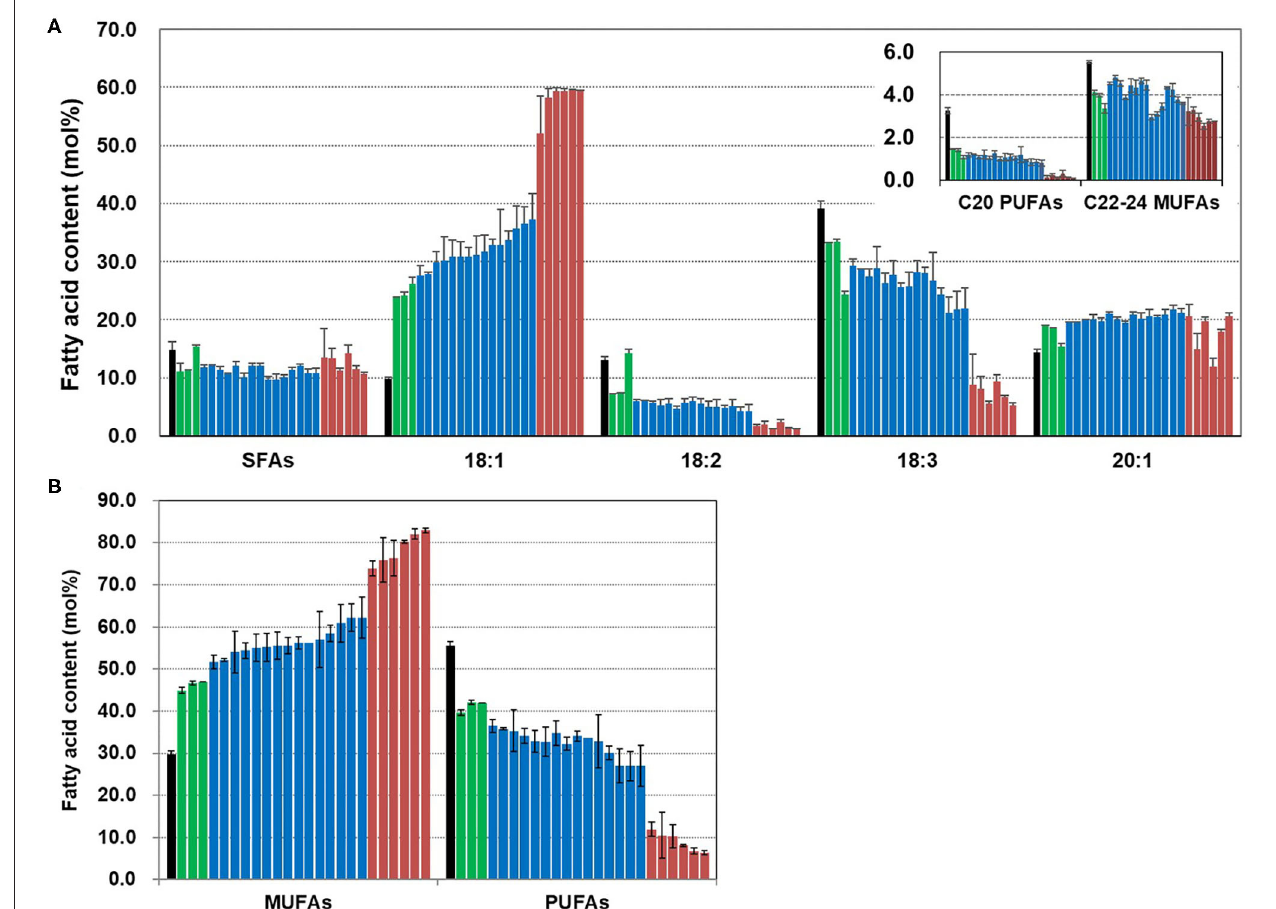
FIGURE 5 | Fatty acid analysis of CsFAD2 KO T 4 Camelina seeds. (A) Fatty acid composition of CsFAD2 KO Camelina seeds showing high-oleic and low-PUFA traits. SFAs, saturated fatty acids containing 16:0, 18:0, 20:0, 22:0, and 24:0; C20 PUFAs, 20:2, and 20:3; C22-24 MUFAs, 22:1, and 24:1. (B) MUFA and PUFA contents of CsFAD2 KO Camelina seeds. Black, green, blue, and brown bars represent WT, aa/bb/CC, aa/bb/Cc, and aa/bb/cc, respectively. The line numbers of green, blue and brown bars are in order as follows. Green bar, EC#5-1-5-2 (EC# is omitted hereafter), 5-6-14-2, and 5-6-24-4; blue bar, 5-1-6-1, 5-6-14-7, 5-6-2-41, 5-7-9-3, 5-26-10-5, 5-26-10-6, 5-44-24-4, 5-44-24-6, 5-6-24-6, 5-26-10-8, 5-6-14-5, 5-1-5-6, 5-7-9-10, 5-7-9-9, and 5-6-24-1; brown bar, 5-1-5-5, 5-1-5-9, 5-1-5-1, 5-1-5-7, 5-6-24-7, and 5-44-24-8. Fatty acid composition was analyzed in triplicate, and error bars indicate standard